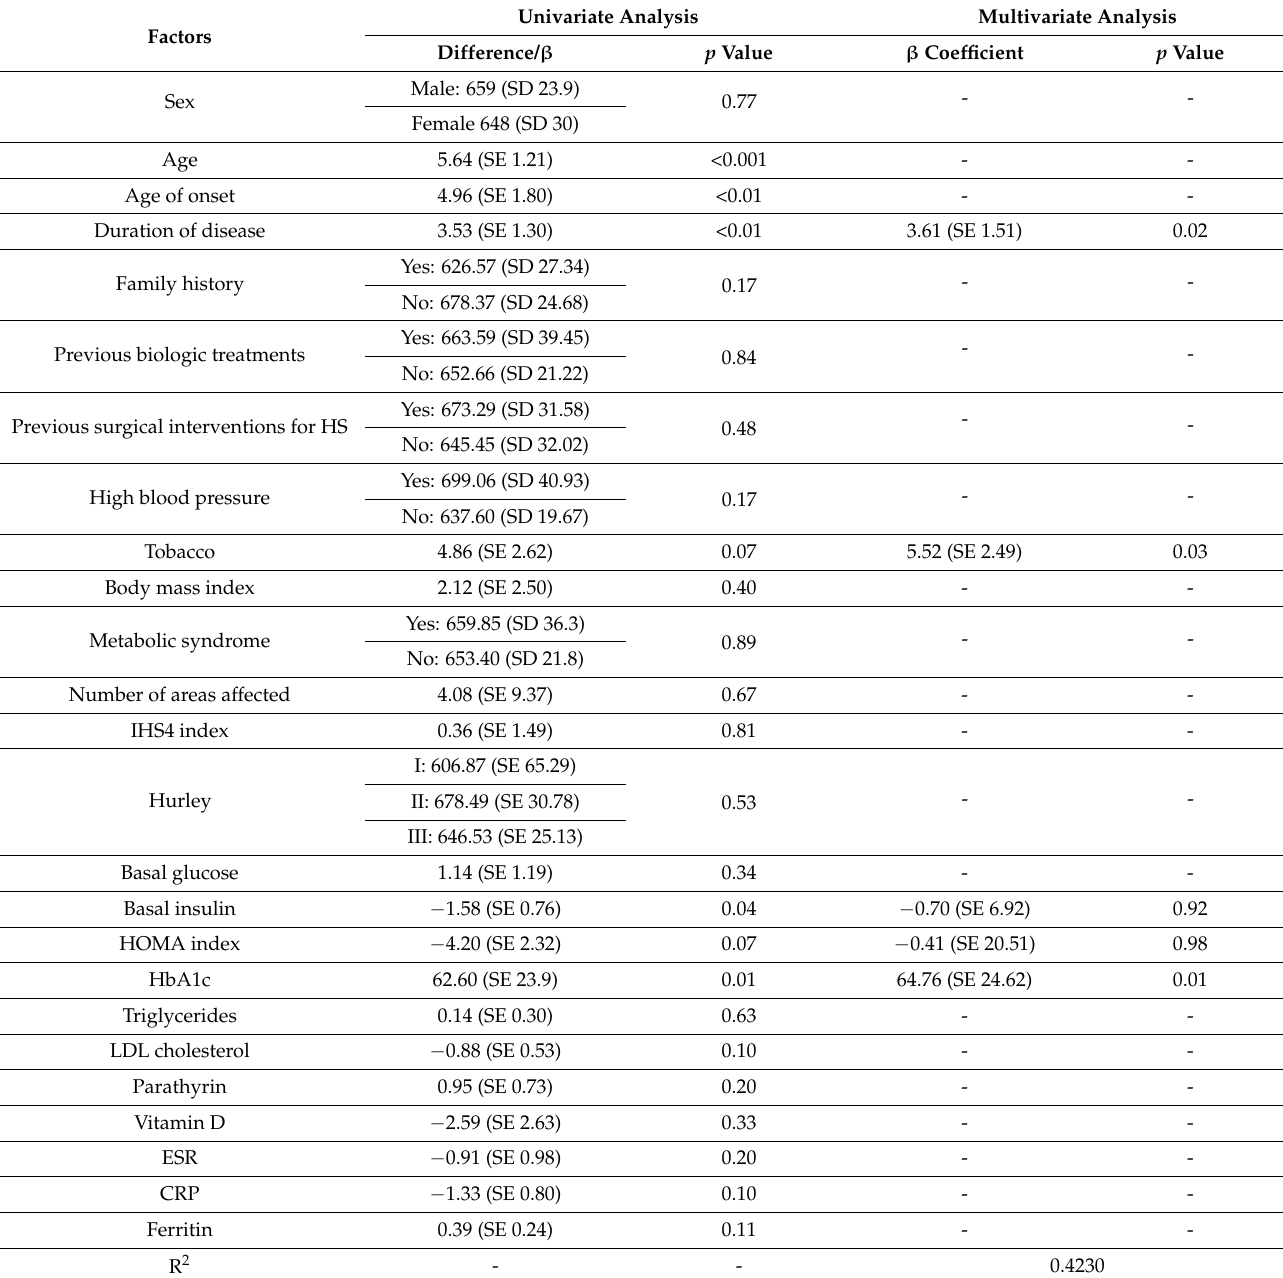
Table 4. Potential clinical and socio-demographic features associated to intima-media